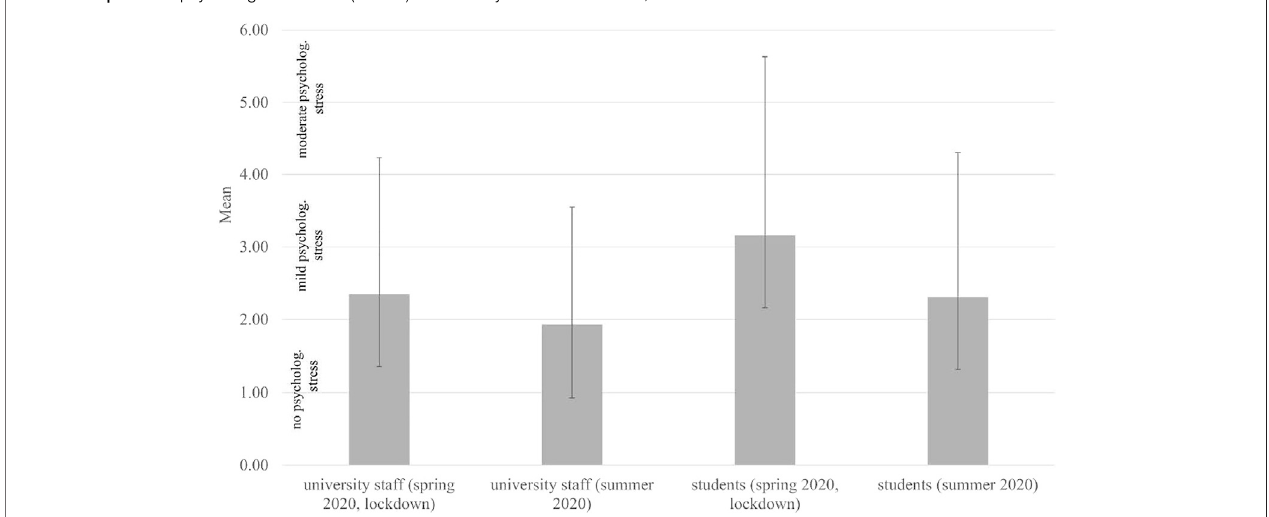
FIGURE 2 | Level of psychological distress (PHQ-4) in university staff and students, over